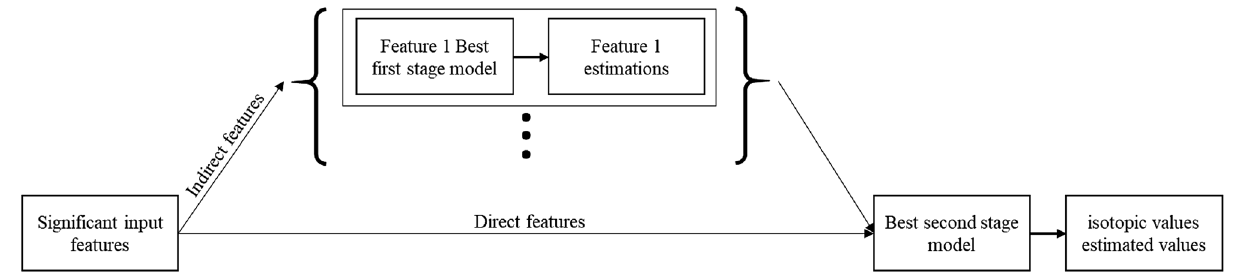
Figure 7. Workflow of the evaluation class for estimating the second-stage